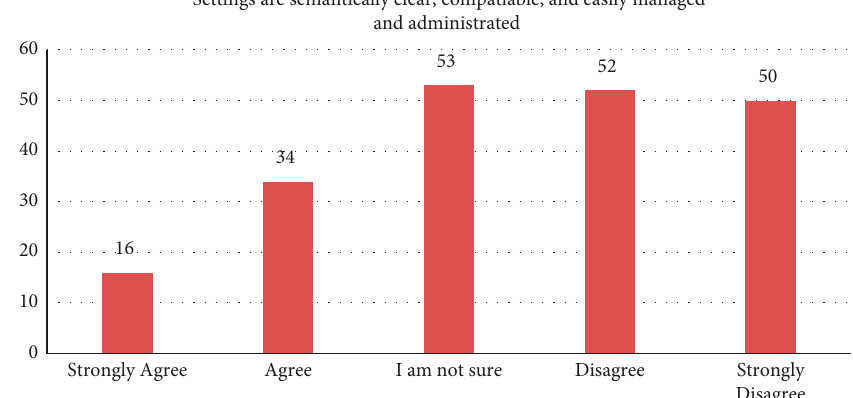
Figure 6: Particpants’ responses regarding the clear settings and easy management of the